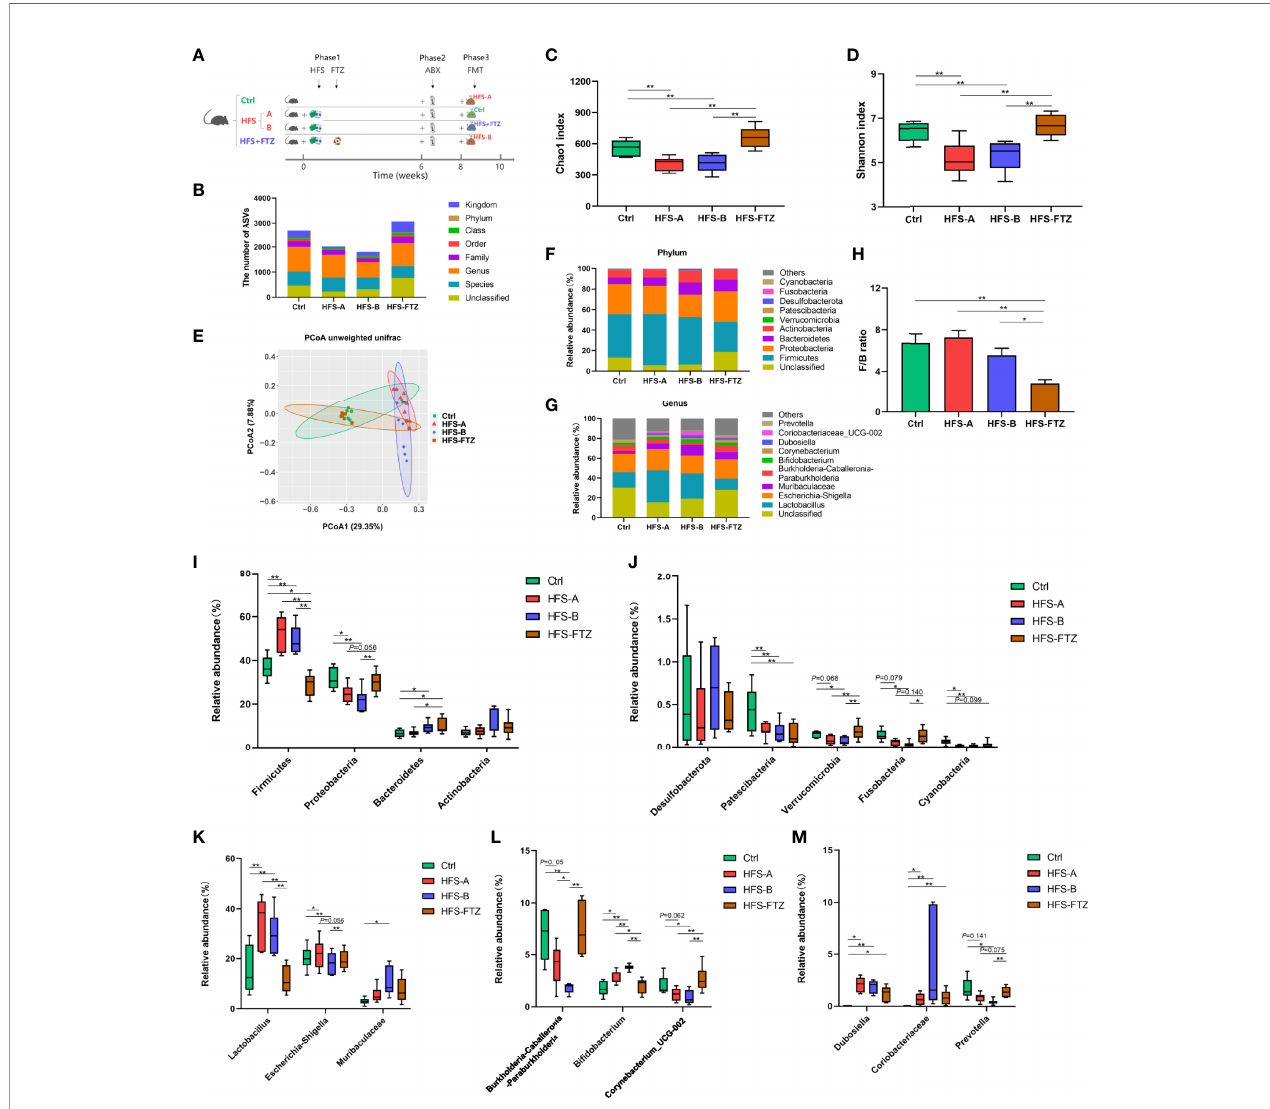
FIGURE 4 | Signi fi cant changes of gut microbiota in response to FTZ treatment. (A) A schematic diagram for Experiment 2. (B) ASV number. (C) Chao1 index. (D) Shannon index. (E) b -Diversity based on unweighted unifrac PCoA. (F) Relative abundance of microbiota compositions at the phylum level. (G) Relative abundance of microbiota compositions at the genus level. (H) Ratio of Firmicutes to Bacteroidetes. (I, J) Relative abundances of the top 9 bacterial phyla, including Firmicutes, Proteobacteria, Bacteroidetes, Actinobacteria, Desulfobacterota, Patescibacteria, Verrucomicrobia, Fusobacteria, and Cyanobacteria. (K – M) Relative abundances of the top 9 bacterial genera, including Lactobacillus , Escherichia-Shigella , Muribaculaceae, Burkholderia-Caballeronia-Paraburkholderia , Bi fi dobacterium , Corynebacterium , Dubosiella , Coriobacteriaceae_UCG-002 , and Prevotella . ∗ p < 0.05, ∗∗ p < 0.01. n = 6~8 per group. ABX, antibiotics; FMT, fecal microbiota transplantation. FTZ, Fufang- Zhenzhu-Tiaozhi capsule; ASV, amplicon sequence variant; PCoA, principal coordinate